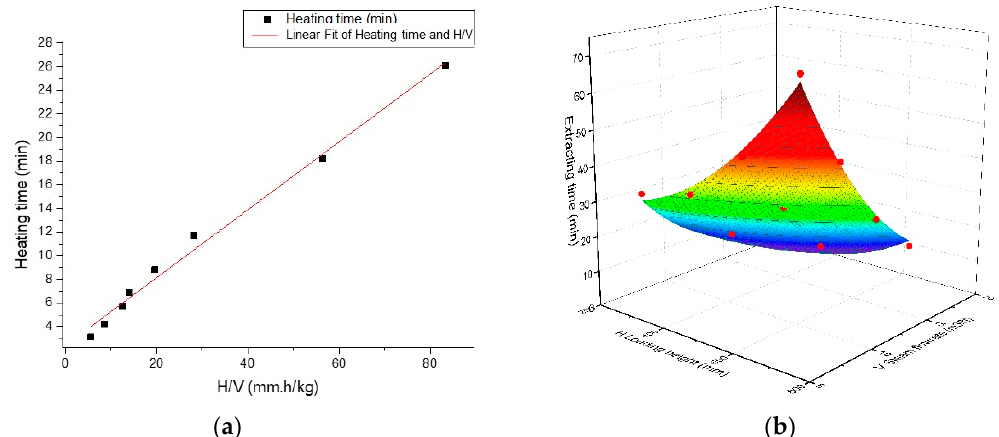
Figure 7. The effect of loading height and steam flowrate on distillation time: ( a ) Heating time linear fit with H/V ; ( b ) Extracting time polynomial fitting with H and V .